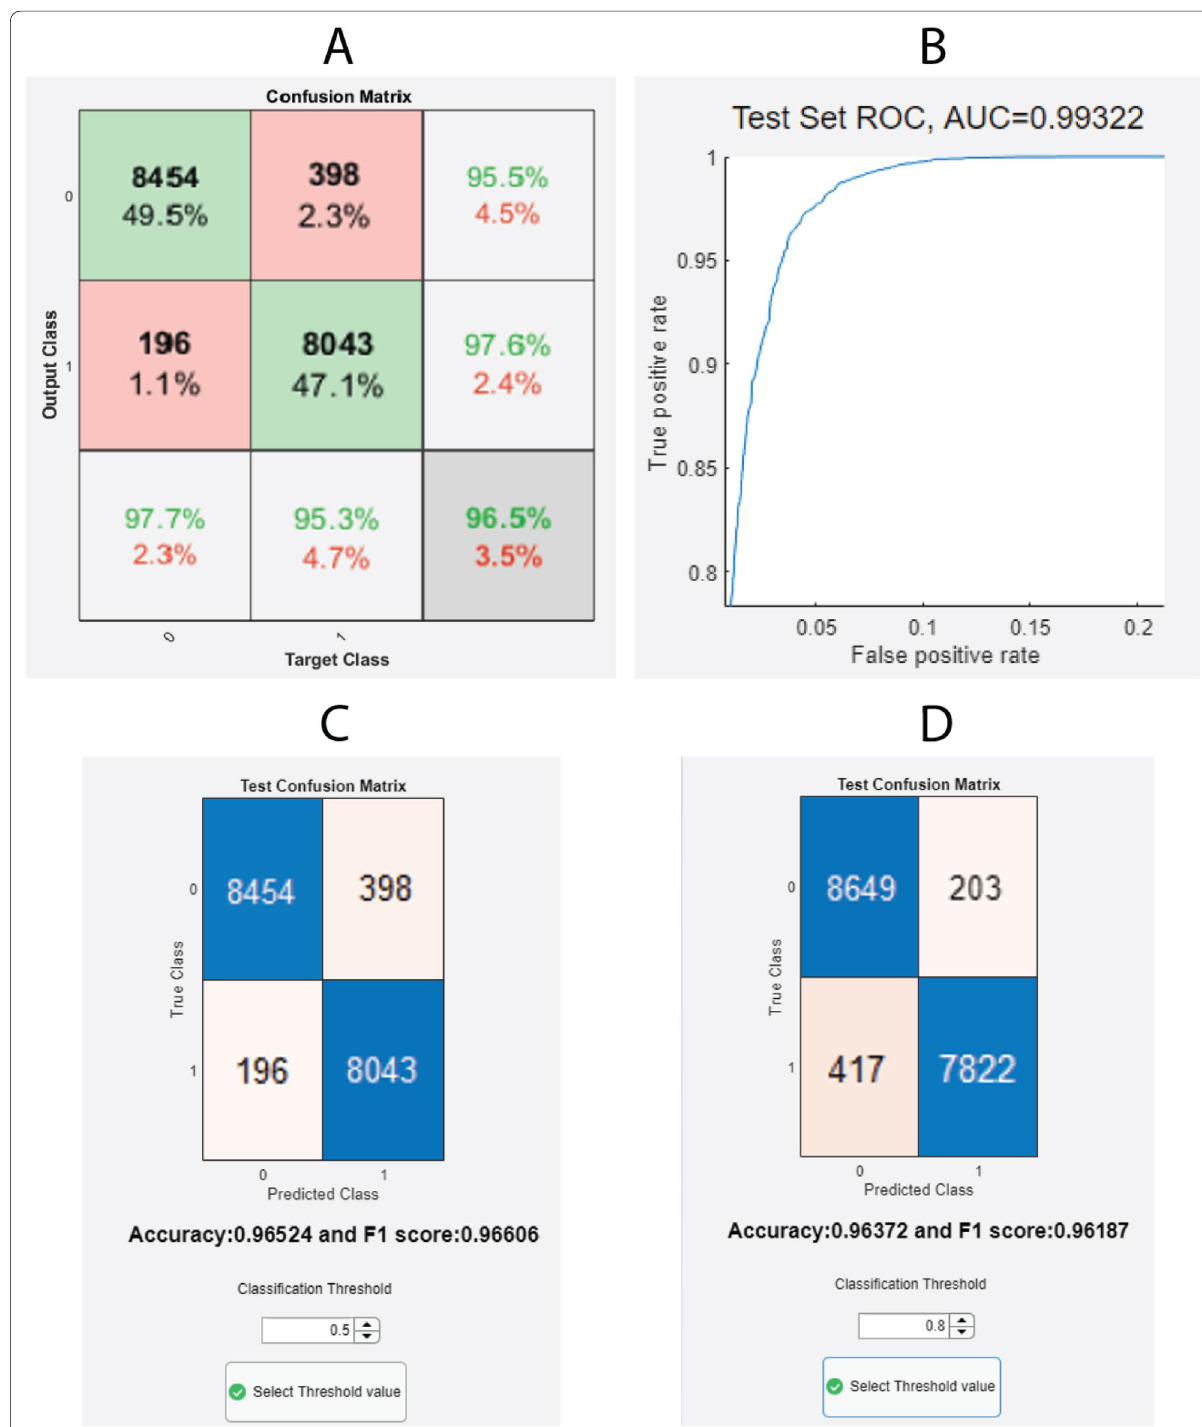
Fig. 11 Screenshots of the toolbox’s network test set results outputs: confusion matrix ( A ), AUROC curve ( B ), threshold selection window with default ( C ), and custom values ( D